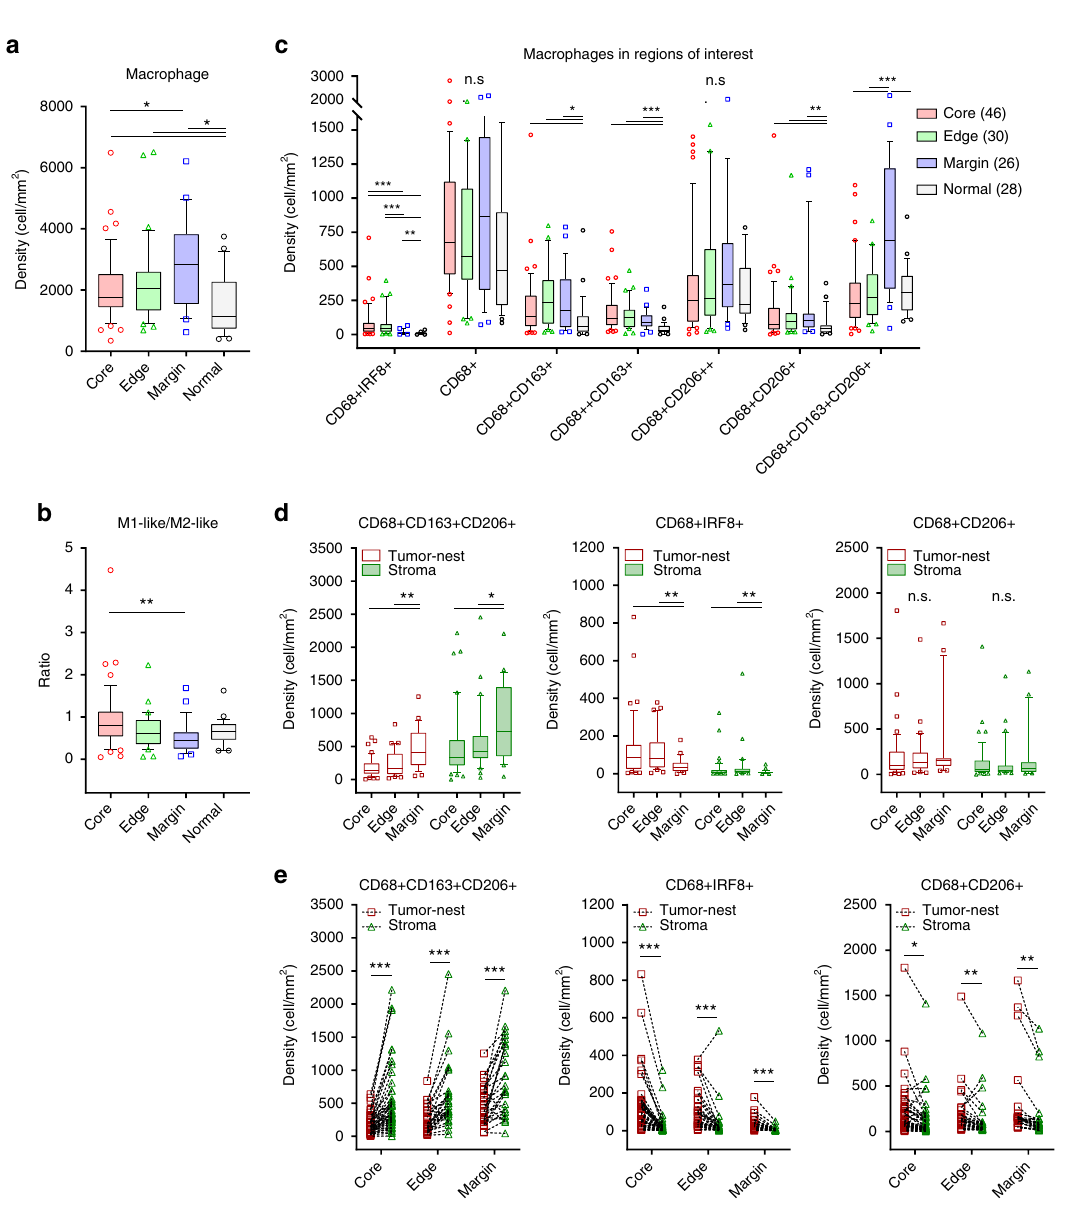
Fig. 2 Distinct distribution of TAM population densities across regions of interest. a – c Spatial distribution of TAM populations: a Overall TAM density, b M1-like to M2-like ratio, and c Density of each TAM population. Core (red circle): n = 46, edge (green triangle): n = 30, margin (blue square): n = 26, normal (white circle): n = 28. d , e Density of selected TAM populations between the Tumor-nest (dark red square) and Stroma (dark green triangle) areas ( d ) among the ROIs and ( e ) in matched (dash line) patient samples. Box and whiskers represent mean ± 10 – 90 percentile. Each point represents one patient. * p < 0.05, ** p < 0.01, *** p < 0.001 and not signi fi cant (n.s.). Mann – Whitney U